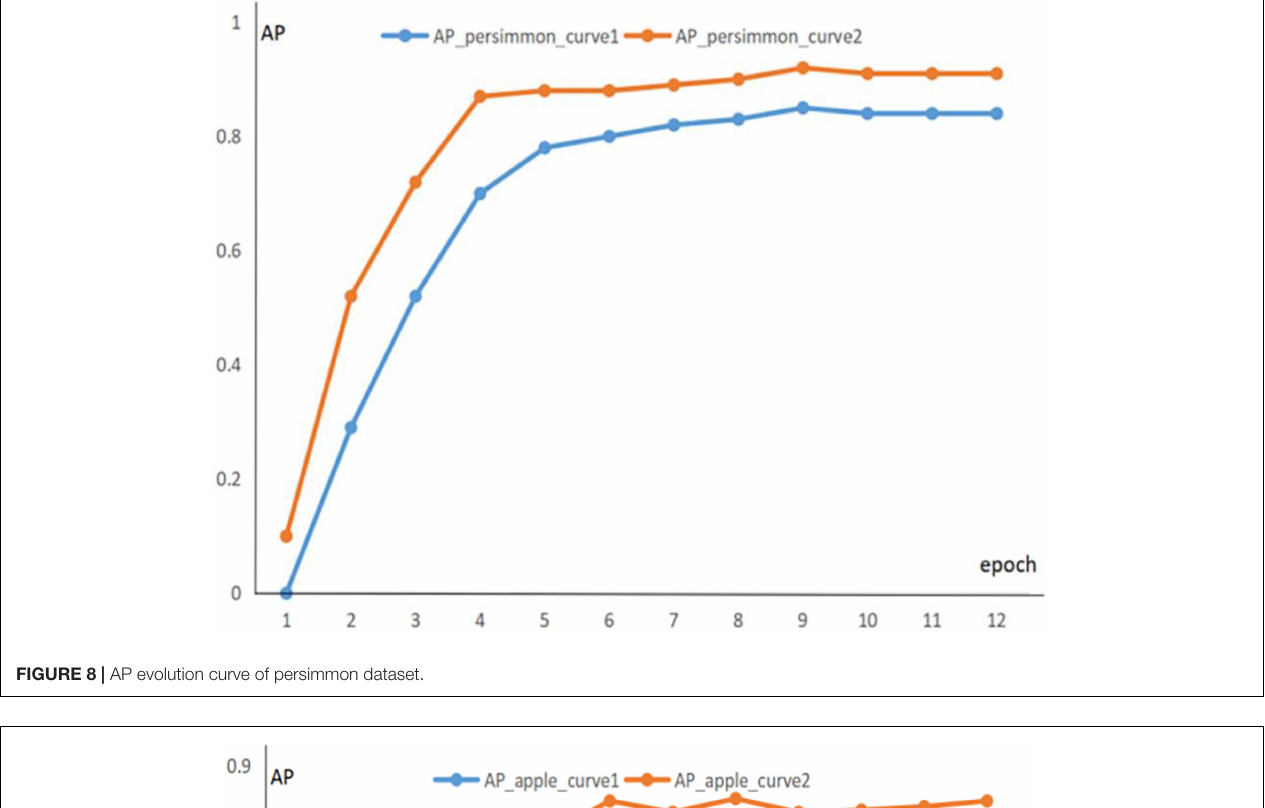
FIGURE 8 | AP evolution curve of persimmon dataset.